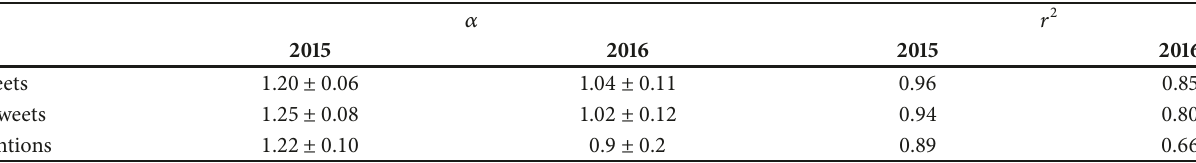
Table 2: Values of the exponents (𝛼) and correlation coefficients ( 𝑟 2 ) of the linear regressions of the log-log plots of tweets, retweets, and mentions with respect to the number of unique users per day shown in Figure 3 for both electoral campaigns. 𝛼